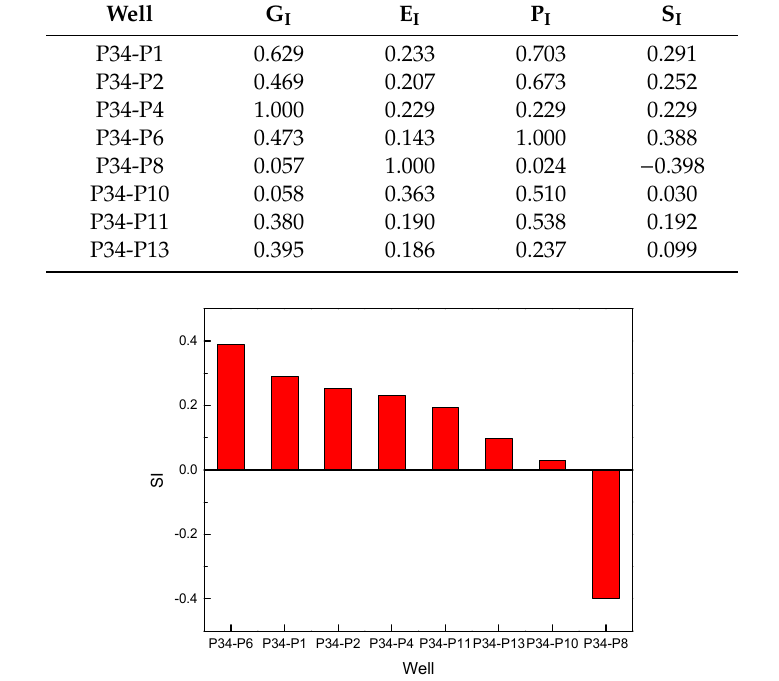
Figure 10. Schematic diagram of well selection results.